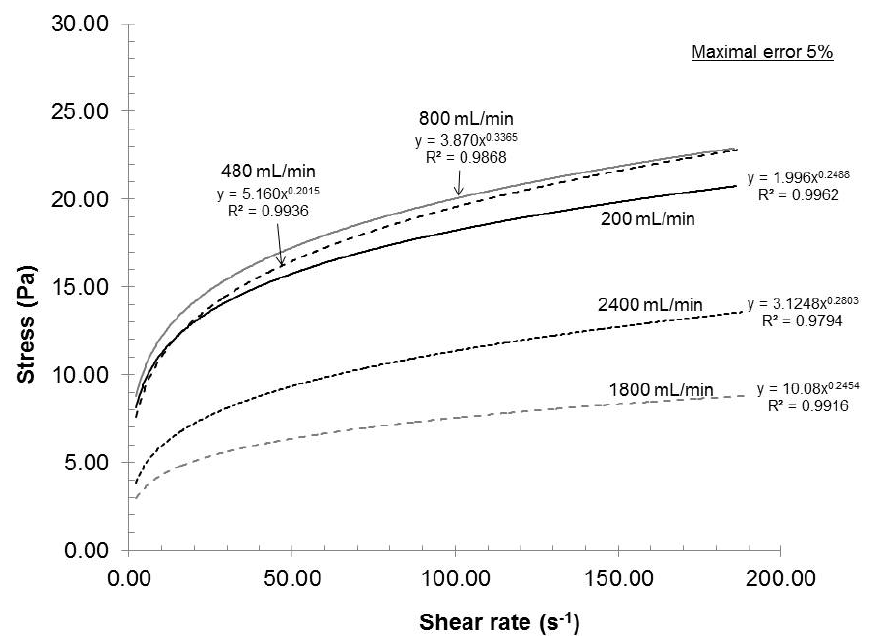
Figure 6. Effect of recirculation rate on the rheological evolution of the